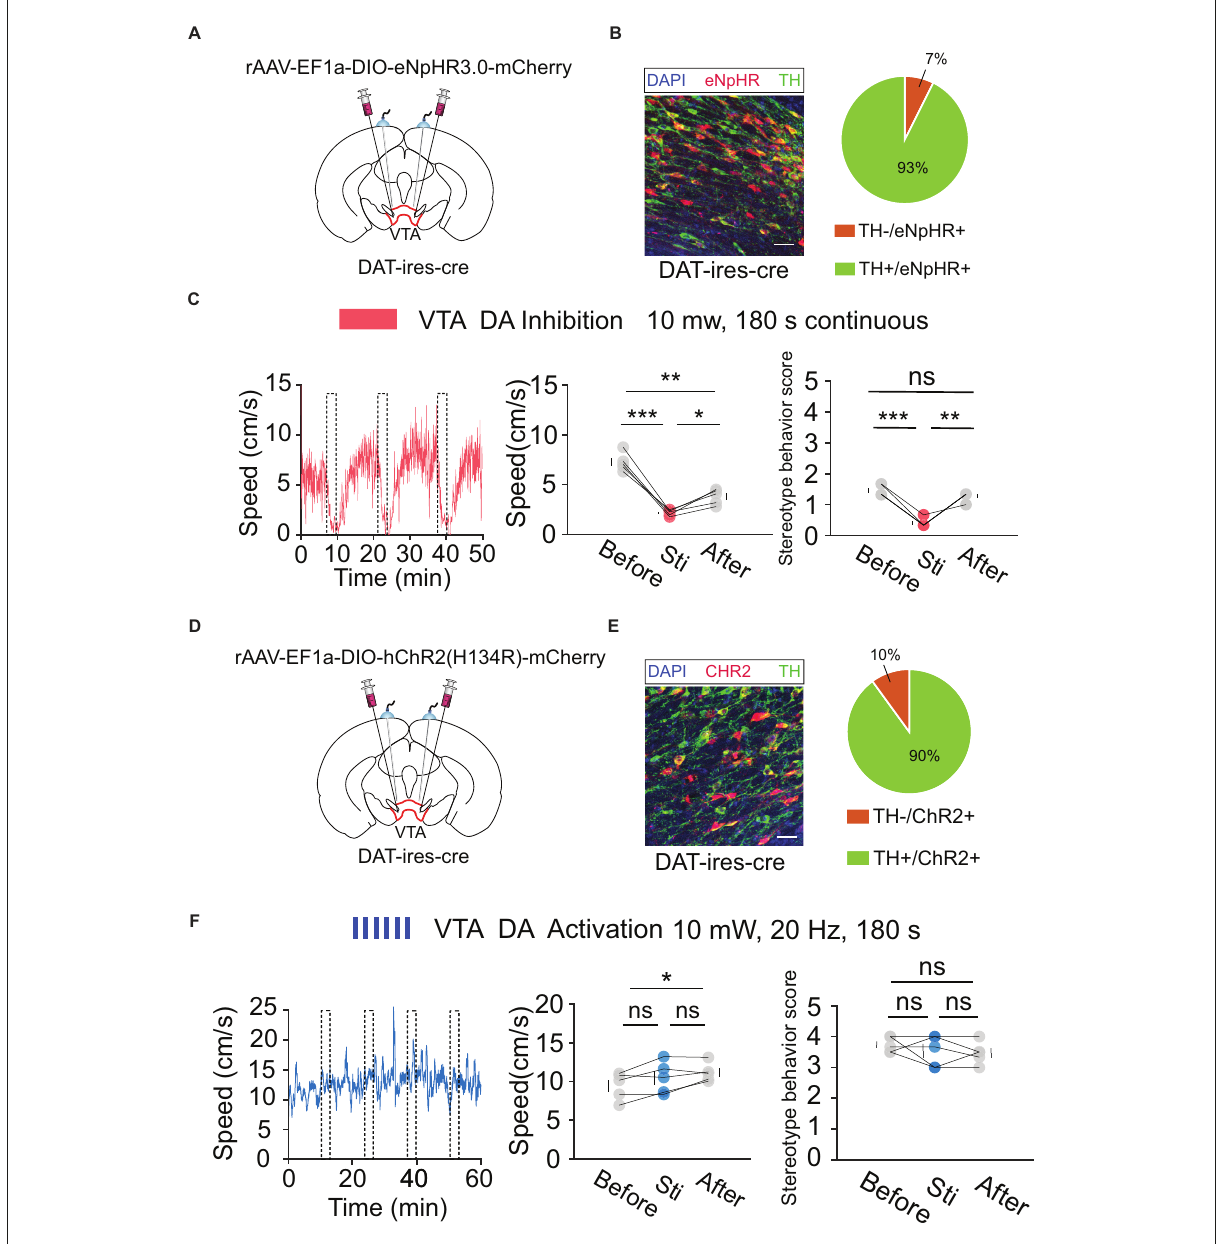
FIGURE5 Optogenetic manipulation of VTA DA neurons. (A) Schematic of virus injection and fiber implantation above the VTA in DAT-ires-cre mice. (B) Successful expression of eNpHR3.0-mCherry in VTA DA neurons and optical fiber implantation above the VTA. The image shows eNpHR + cell bodies (red) and TH+ neurons (green) in DAT-ires-cre mice. Scale bar, 20 µ m. TH, tyrosine hydroxylase. Right: quantification of expression of TH in eNpHR-positive neurons in the VTA of DAT-ires-cre mice ( n = 3 sections per animal from five animals). (C) Left: the movement speed in response to 180 s photo inhibition of VTA DA neurons in DAT-ires-cre mice; middle: quantification of movement speed before, during, and after VTA DA photoinhibition. * p < 0.05, ** p < 0. 01, *** p < 0.001; ns, no significance. one-way ANOVA. All error bars represent ± SEM. n = 5 mice; right: quantification of the stereotyped behavior scores before, during, and after VTA DA photoinhibition. ** p < 0.01, ∗∗∗ p < 0.001, one-way ANOVA. All error bars represent ± SEM. n = 5 mice. (D) Schematic of viral injection and fiber implantation above the VTA in DAT-ires-cre mice. (E) Successful expression of hChR2 (H134R)-mCherry in VTA DA neurons and optical fiber implantation above the VTA. The image shows hChR2 + cell bodies (red) and TH+ neurons (green) in DAT-ires-cre mice. Scale bar, 20 µ m. TH, tyrosine hydroxylase. Right: quantification (pie chart) of expression of TH in hChR2-positive neurons in the VTA of DAT-ires-cre mice ( n = 3 sections per animal from five animals). (F) Left: the movement speed in response to 10 mW, 20 Hz, 180 s photoactivation of VTA DA neurons in DAT-ires-cre mice after intraperitoneal injection of MK-801. Middle: quantification of the movement speed before, during, and after VTA DA photoactivation. * p < 0.05, one-way ANOVA. All error bars represent ± SEM. n = 5 mice; right: quantification of the stereotyped behavior scores before, during, and after VTA DA photoactivation. One-way ANOVA. All error bars represent ± SEM, n = 5